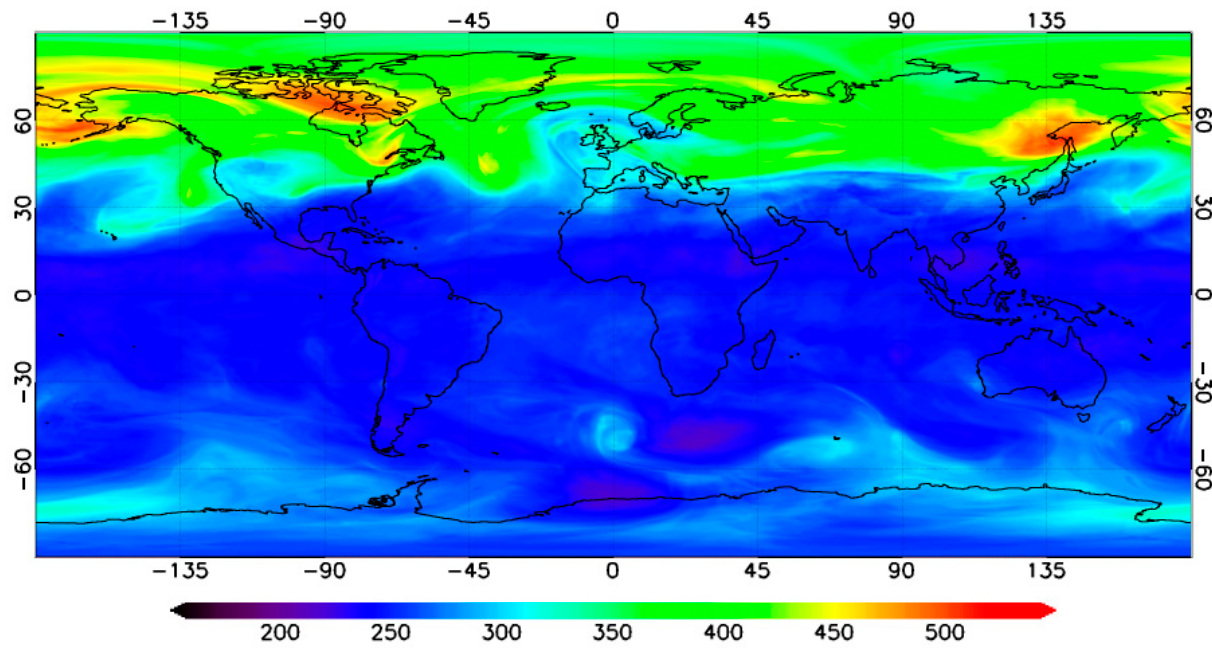
Figure 8. ECMWF total ozone amount (DU) analysis at 06Z 2 March 2021. Figure 9 is the difference of the two absolute differences defined by Equation